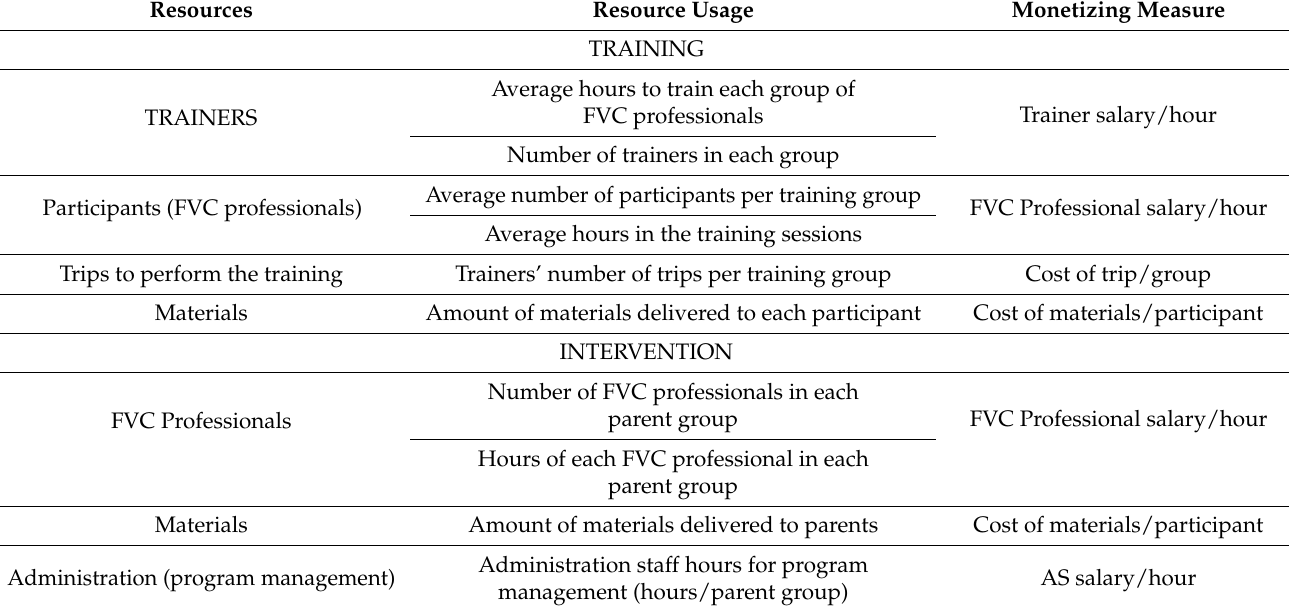
Table 2. Cost valuation: resources, resource usage, and monetizing